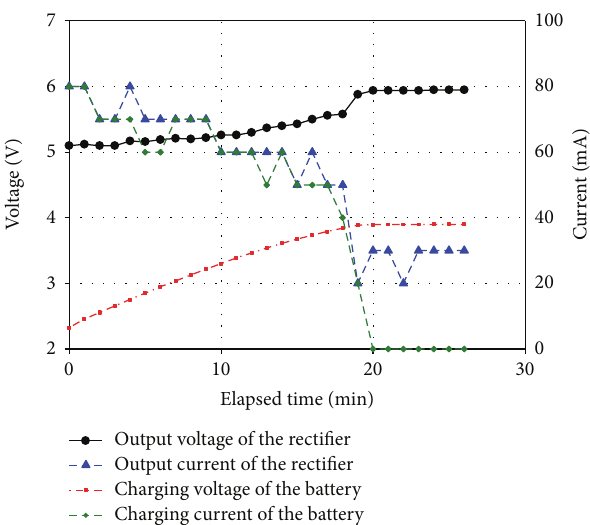
Figure 11: Time domain characteristics of voltage and current at the rectifier and the battery.